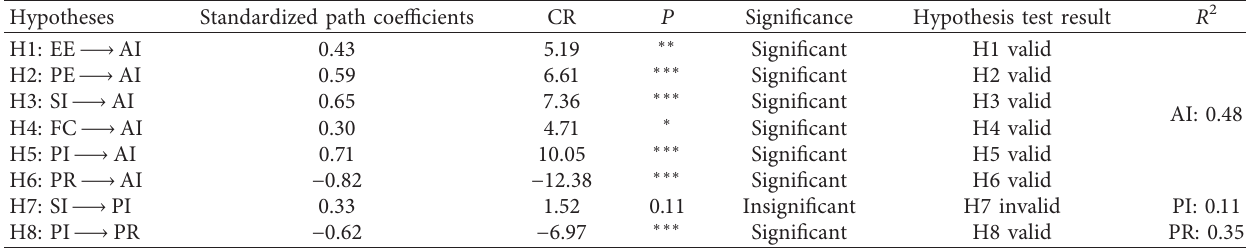
Table 7: Standardized path analysis results of the structural model.